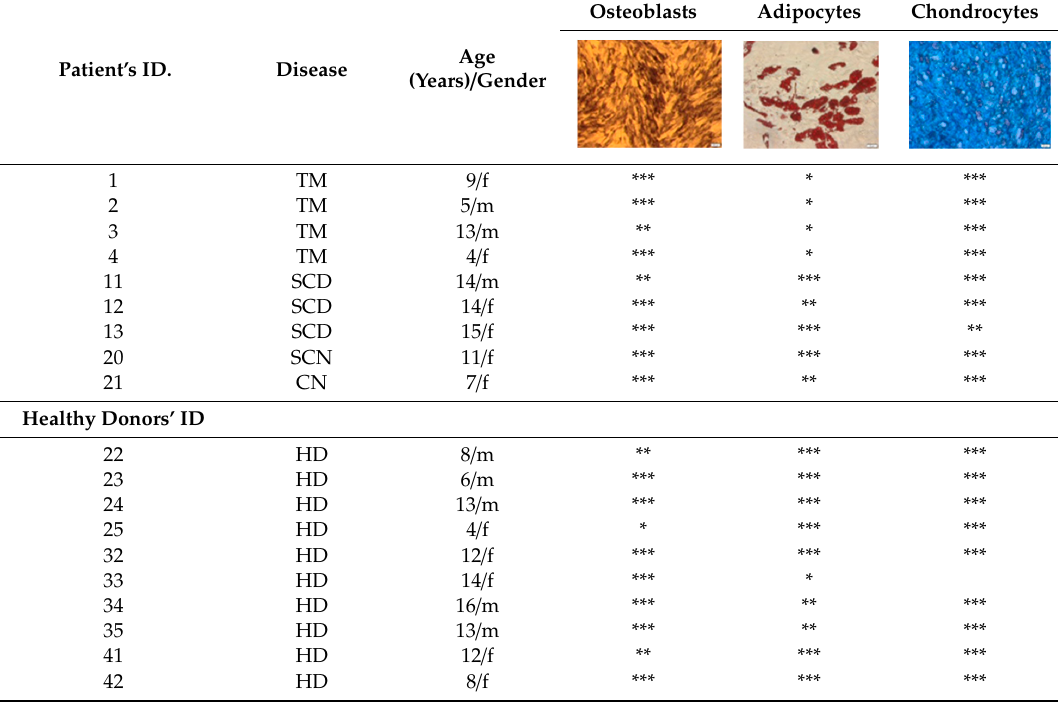
However, thalassemic MSCs in addition to normal differentiation into osteoblasts and chondrocytes show a considerably weaker differentiation into adipocytes (Table 2). Table 2. Differentiation potential of MSCs from patients with NMHD and healthy donors. TM = thalassemia major, SCD = Sickle Cell Disease, SCN = Severe Congenital neutropenia, CN = Congenital Neutropenia, H.D. = Healthy donor, f = female, m = male, differentiation potential labeled with asterisks as: * weak, ** good and *** very good.